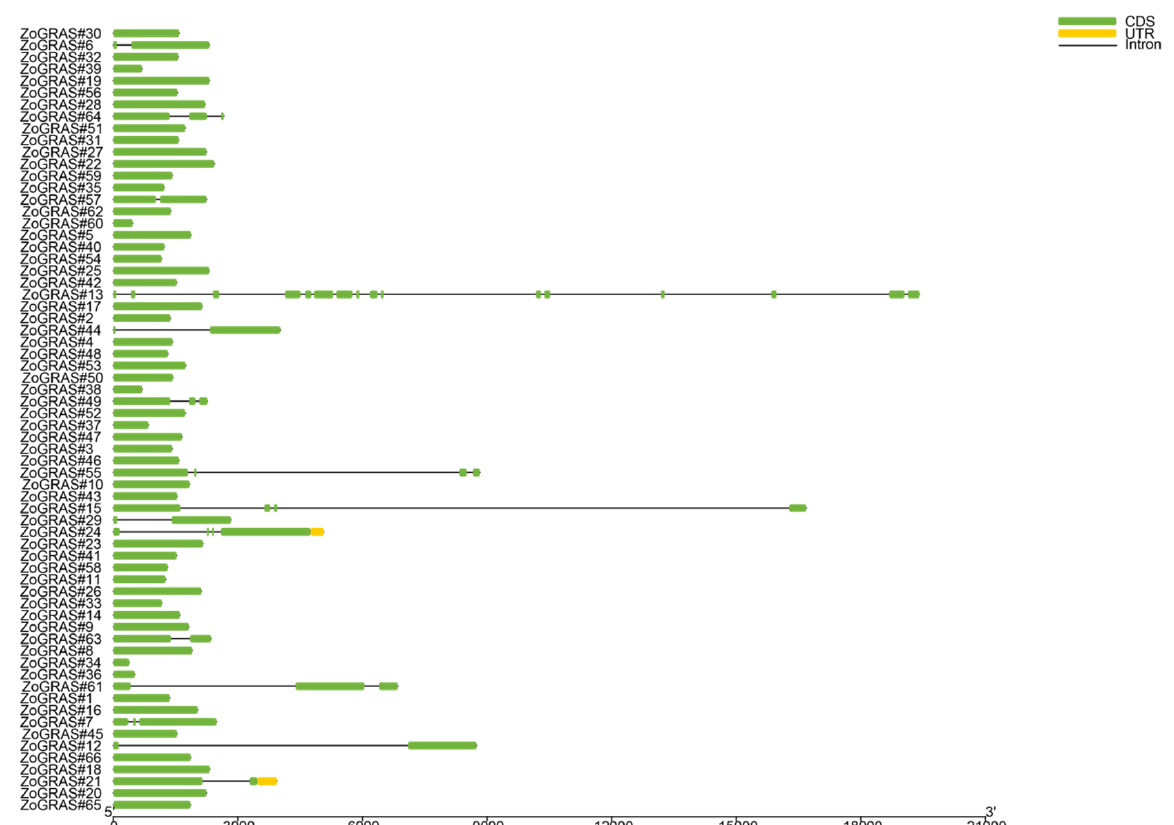
Figure 3. Gene structure of GRAS genes in ginger. Yellow boxes represent untranslated regions, green boxes represent exons, black lines represent introns.